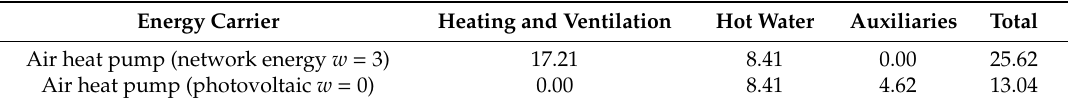
Table 13. The annual final energy demand (kWh / (m 2 · year)) for the multi-family building at Akacjowa Street in Goleniow (Cascade of air heat pumps with photovoltaic installation).